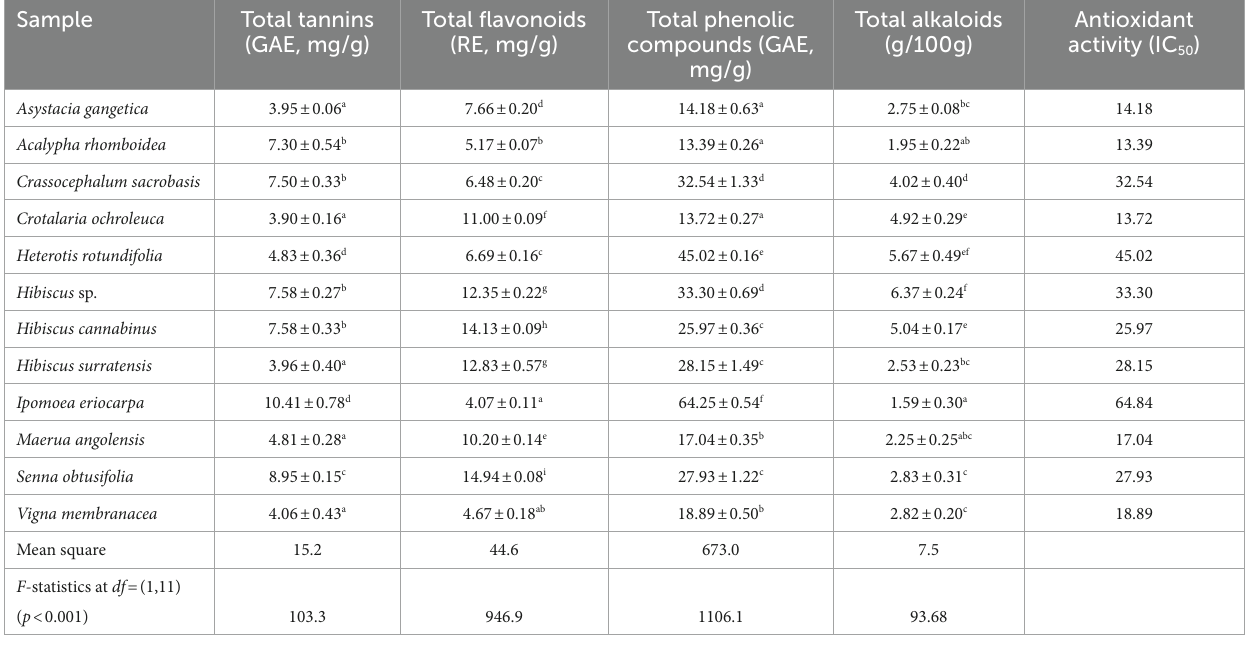
GAE, mg/g: milligram of gallic acid equivalents per gram of dry residue, RE, mg/g: rutin equivalent per gram residue, IC 50 of ascorbic acid = 12.82 ppm. Values are expressed as means ± SD ( n = 3). Means in columns followed by different letters indicate significant difference between different plant species at the p < 0.05 levels by Tukey HSD post hoc